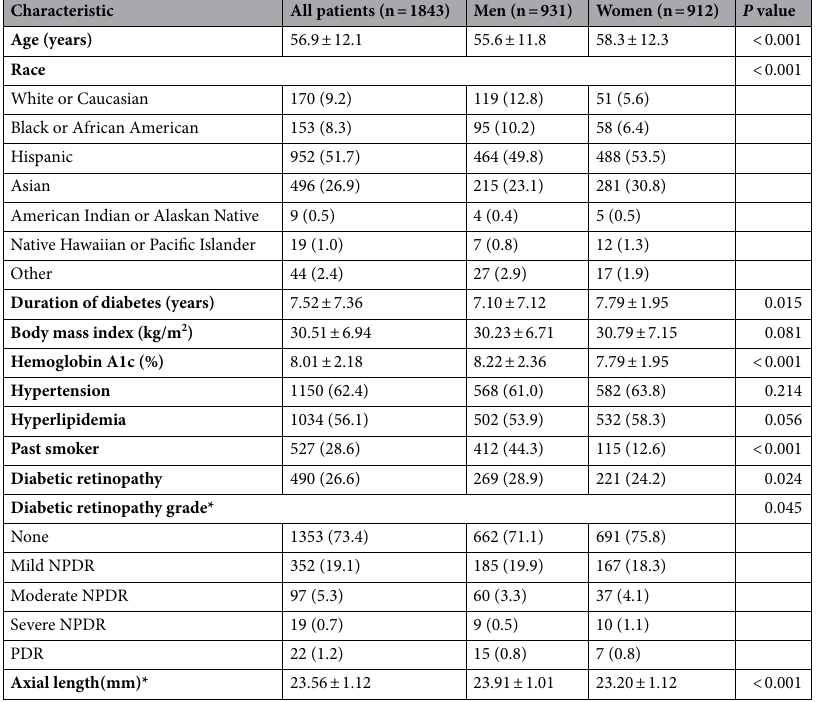
Table 1. Demographic and clinical characteristics of patients. Data are presented as a mean ± standard deviation or raw counts (percentage) as appropriate for each variable. NPDR non-proliferative diabetic